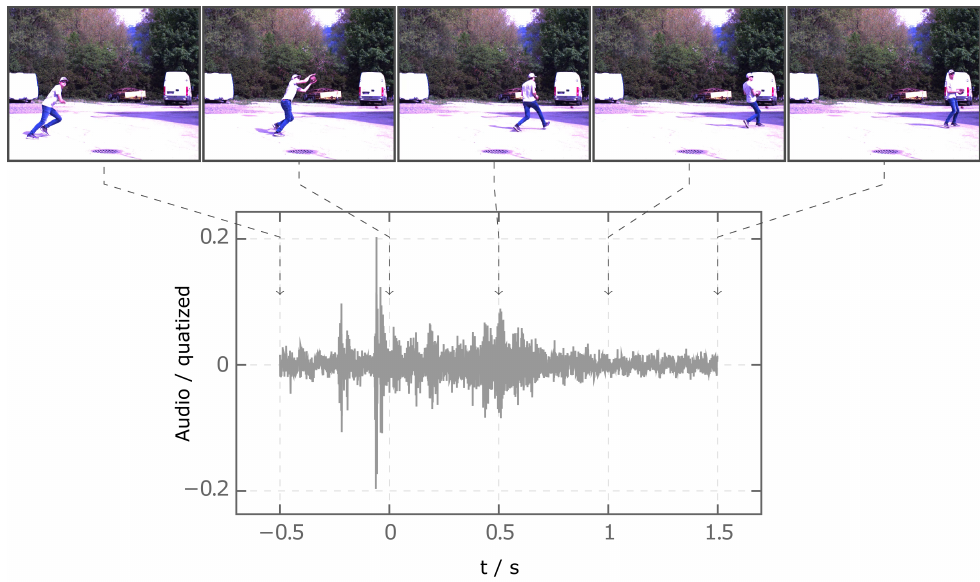
Figure 2. Processed audio and video data of class Catch in a synchronized fashion. Every extracted frame is connected to the specific time stamp in the audio